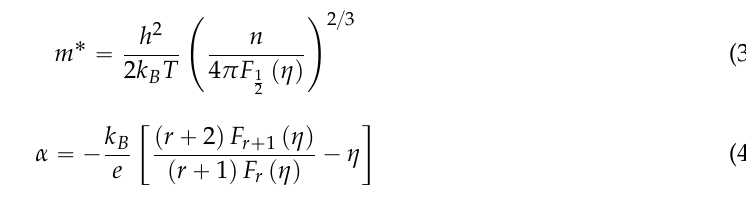
Figure 8. Temperature dependence of Seebeck coefficient ( α ) of C 60 /Cu 2 SnSe 3 composites.